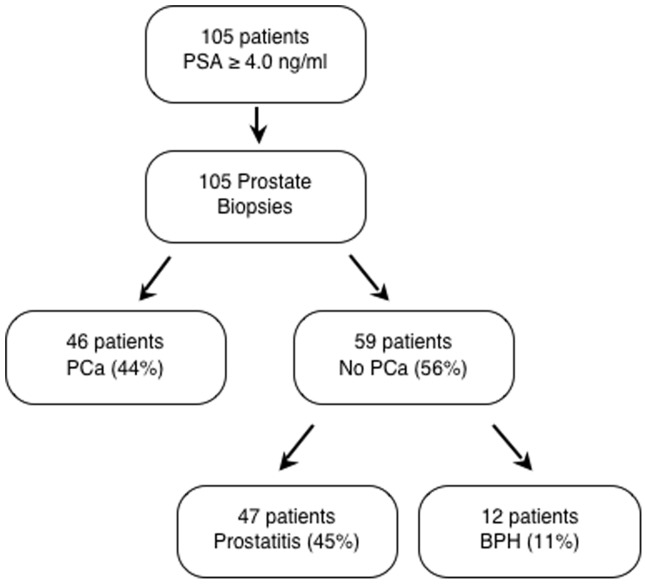
Flow diagram showing that PSA screening results in a high percentage of unnecessary biopsies.One hundred and five consecutive patients with elevated PSA levels underwent prostate biopsy. Forty-six of the 105 patients (44%) were diagnosed with PCa, and fifty-nine patients (56%) showed no evidence of cancer. PCa: Prostate Cancer BPH: Benign Prostatic Hyperplasia.